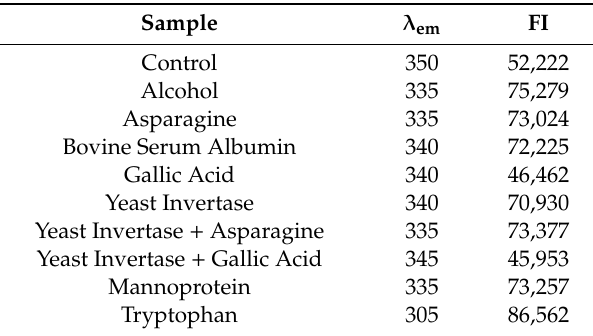
Table 3. Emission wavelength and the corresponding fluorescence intensity following λ ex 278